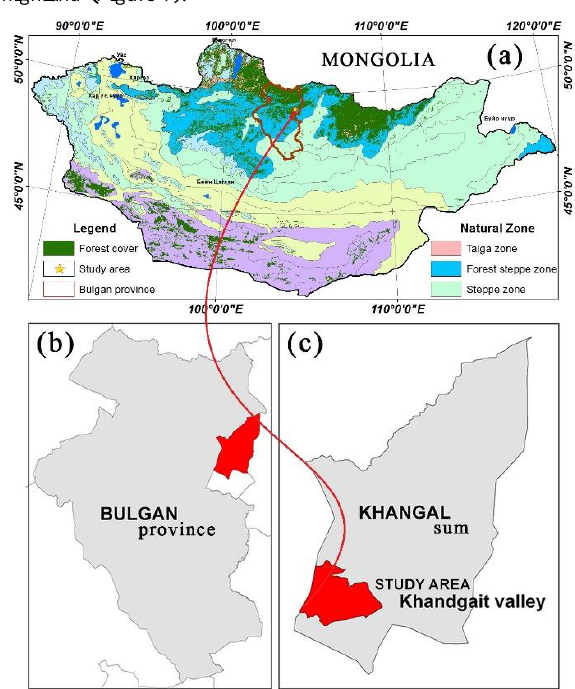
Figure 1. Location map (b) The distribution of natural zones in Mongolia and (b) Khangal soum in Bulgan province (c) the study area whit the red color